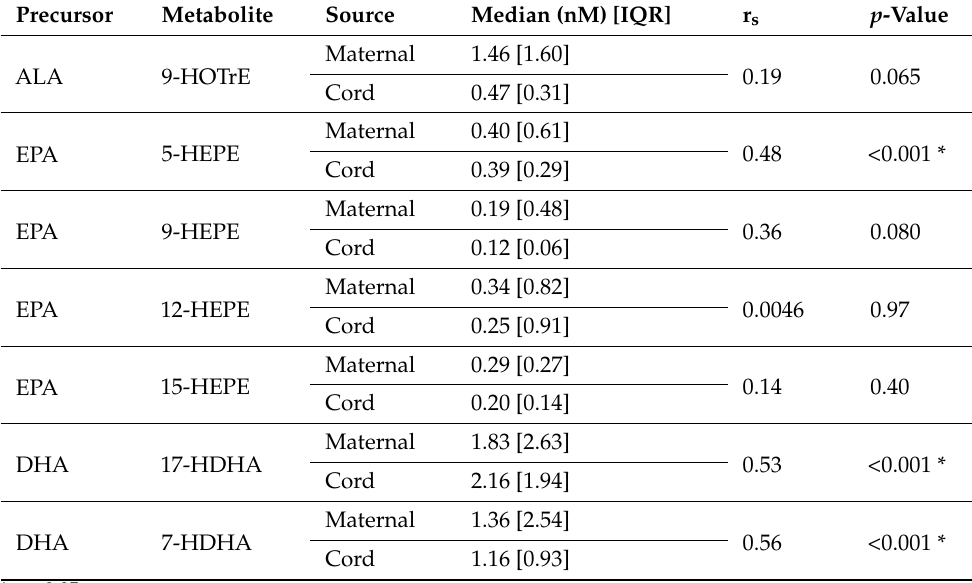
Table 7. Maternal and cord oxylipin concentrations and correlations for n-3